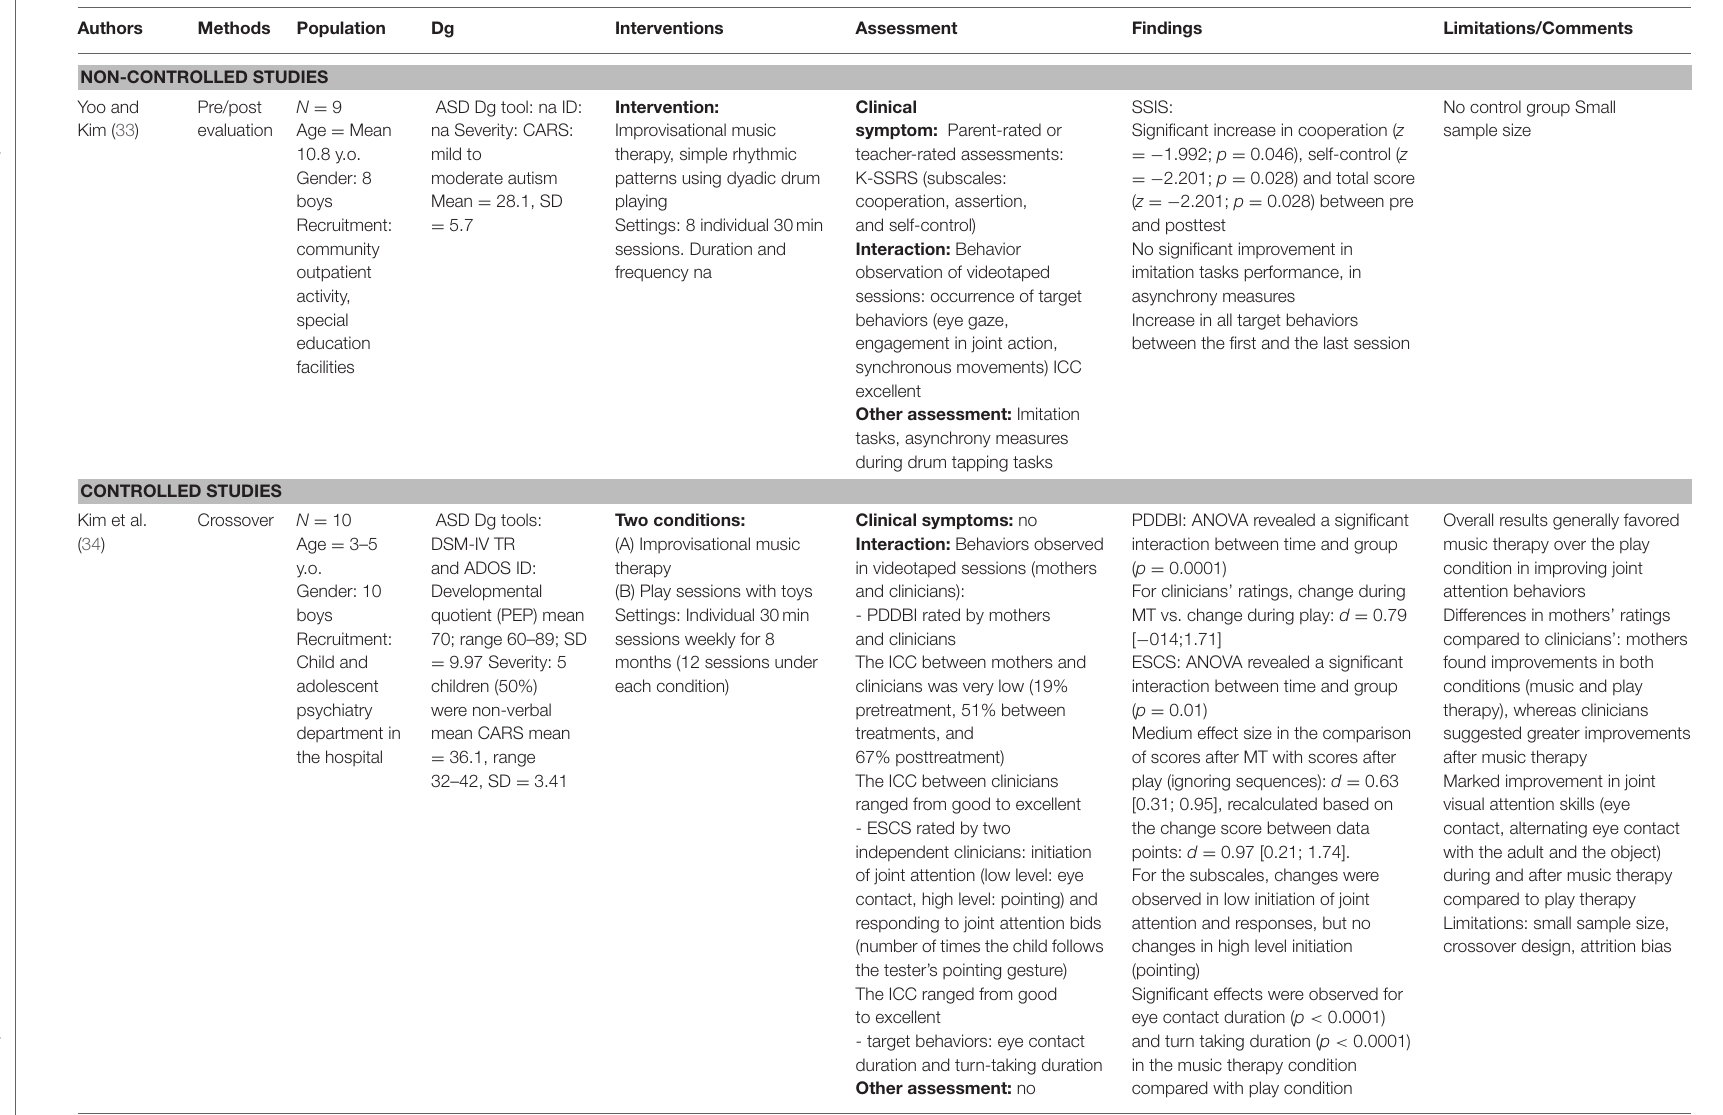
TABLE 2 | Studies assessing improvisational music therapy in patients with autism spectrum disorder